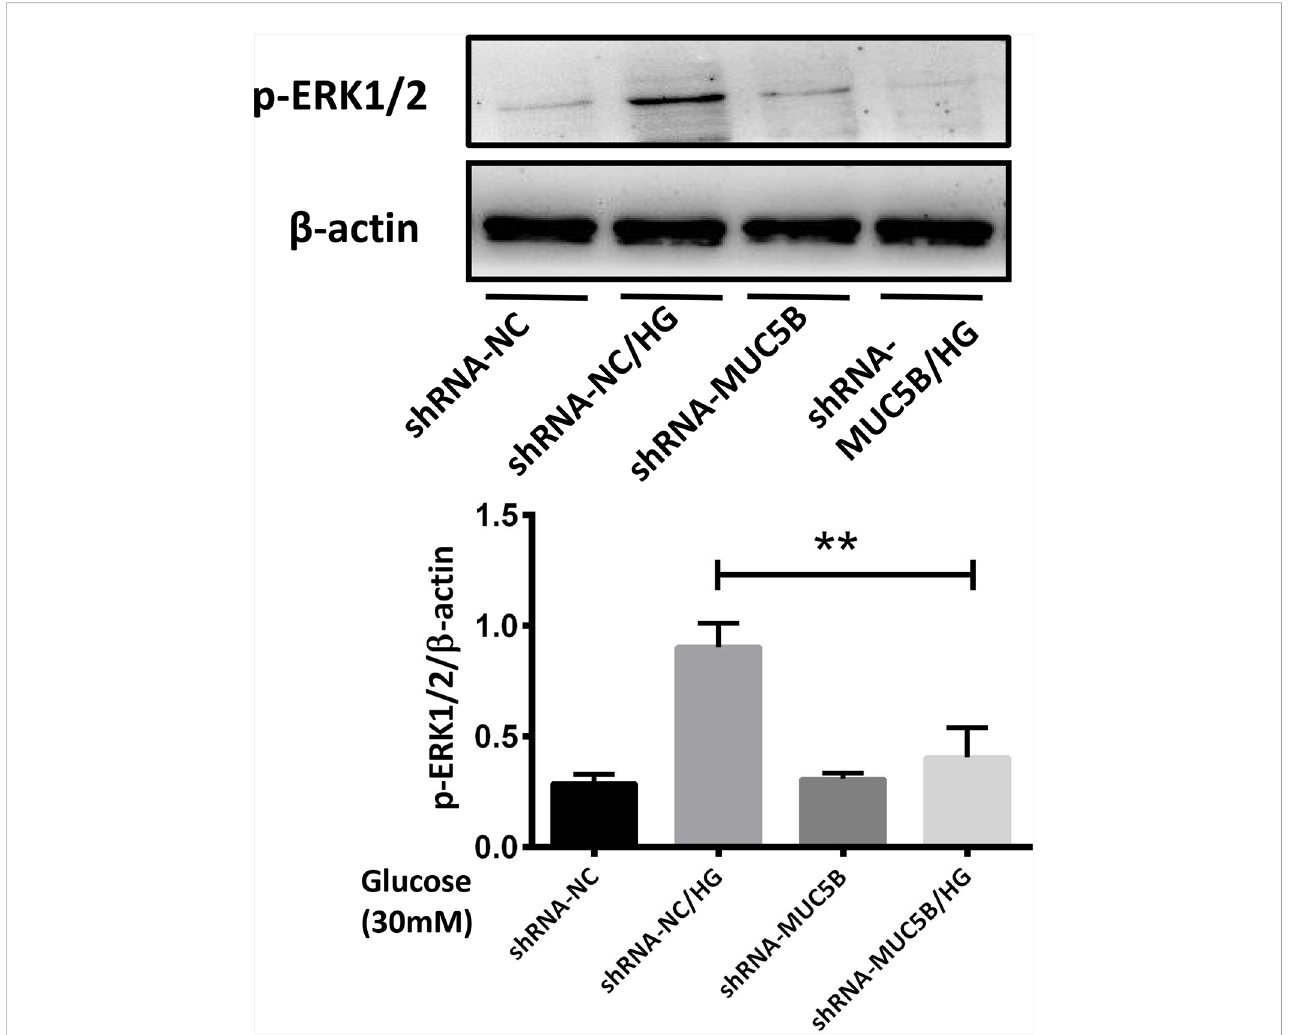
FIGURE 8 MUC5B promoted ERK1/2 activation in BEAS-2B cells stimulated by high glucose. Compared with high glucose group, p-ERK1/2 in the MUC5B knockdown cells stimulated by 30mM glucose for 30min was signi fi cantly down-regulated (** P < 0.01). The blots and densitometry analysis data are representative of three independent experiments. ** P <